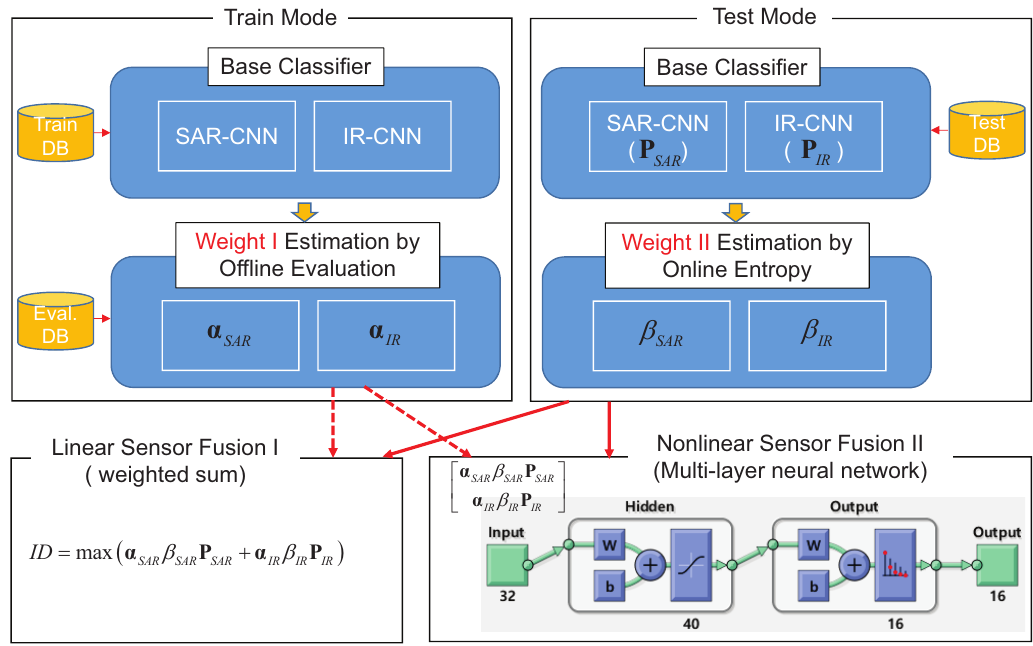
Figure 3. Proposed DW-SIF system for ground target